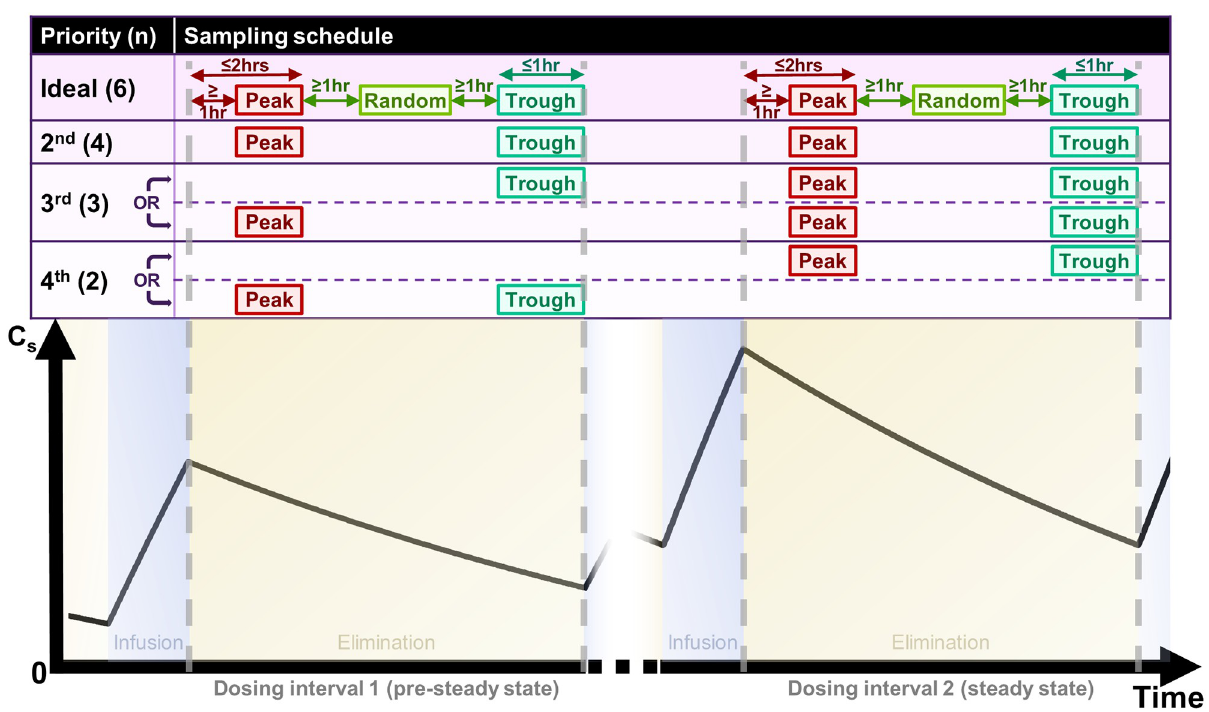
Fig 3. Details of the C s sampling schedule with respect to the dosing schedule. C s : serum vancomycin concentration. n: number of C s measurements in the schedule. Note that the time separation requirements for peak, random, and trough C s are only shown in the ideal sampling schedule. The same set of requirements applies for all proposed schedules with lower